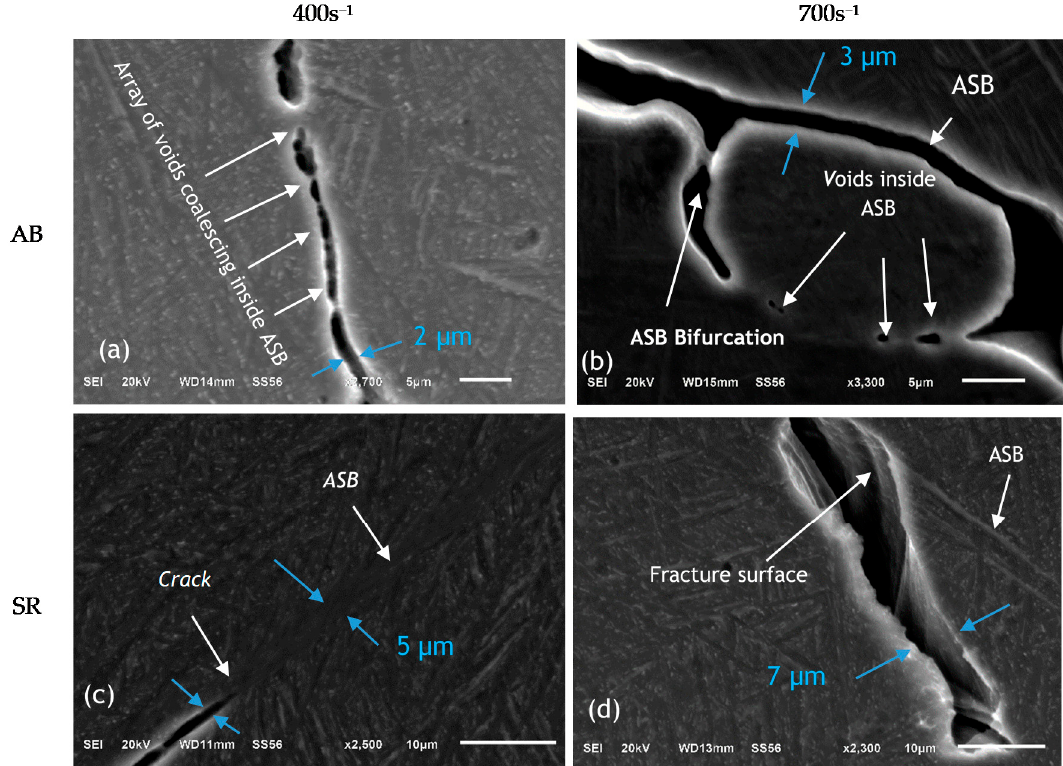
Figure 13. SEM-SEI of deformed adiabatic shear bands for AB samples ( a , b ), while panels ( c , d ) show the SR samples ( a , c ) tested at a strain rate of 400 s − 1 and ( b , d ) at 700 s − 1 .